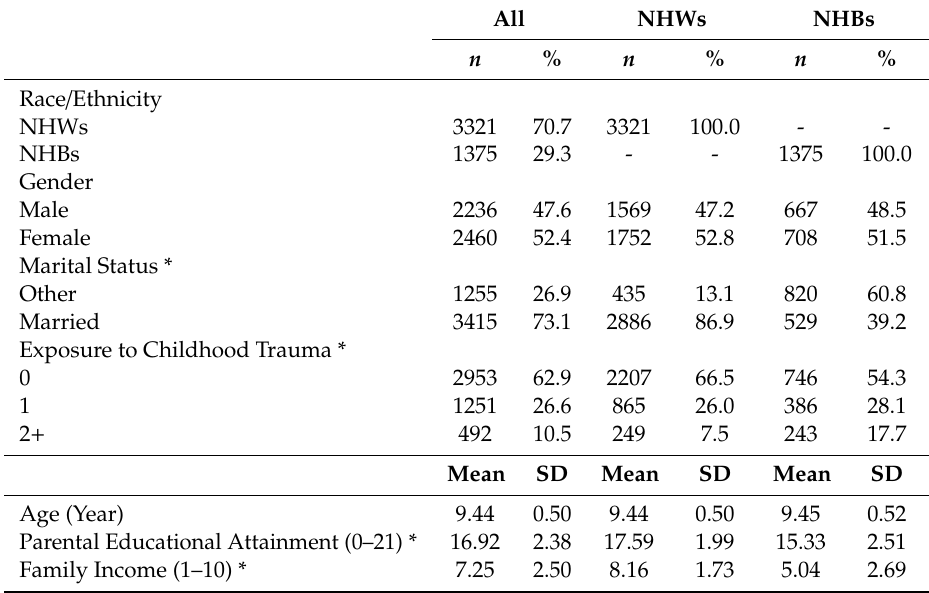
Table 1. Socio-demographic data overall and by race / ethnicity ( n = 4696)